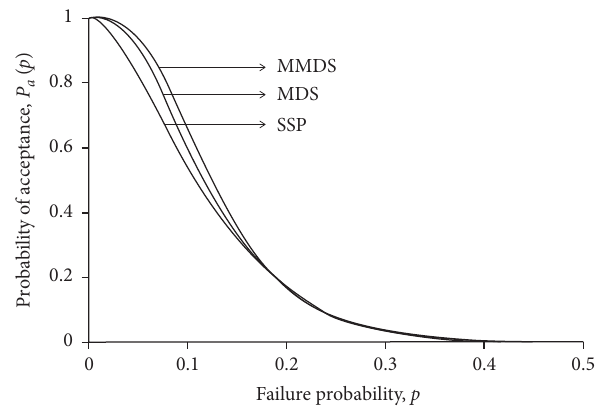
Figure 2: OC curves of the proposed plan, MDS sampling plan, and